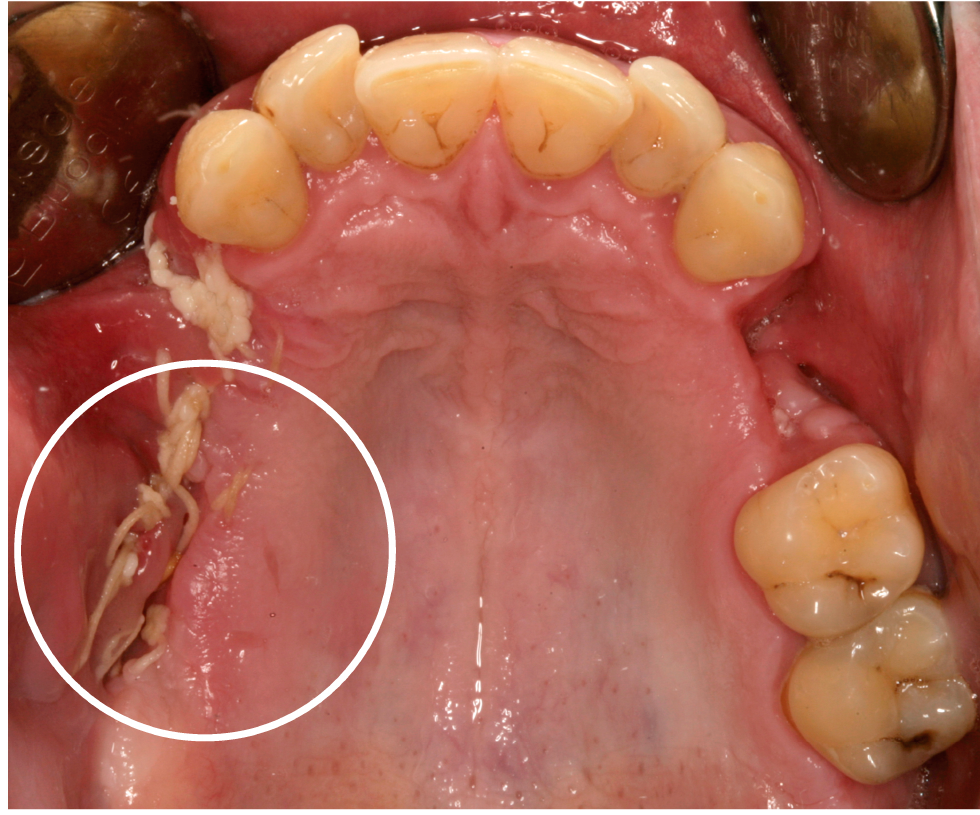
Figure 2. Twenty-one days postoperatively the wound bed still looked fragile and not “stage-related” (white circle). After the removal of the sutures, wound bed has immediately ruptured again [9].